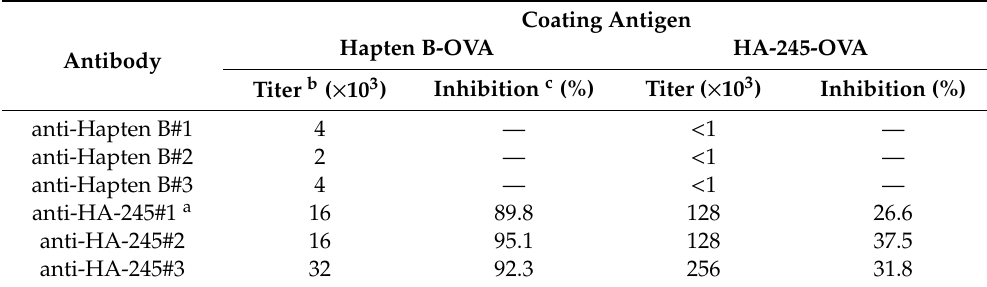
Table 1. Characterization of anti-HA serum obtained after the fourth immunization by competitive and non-competitive ELISA.